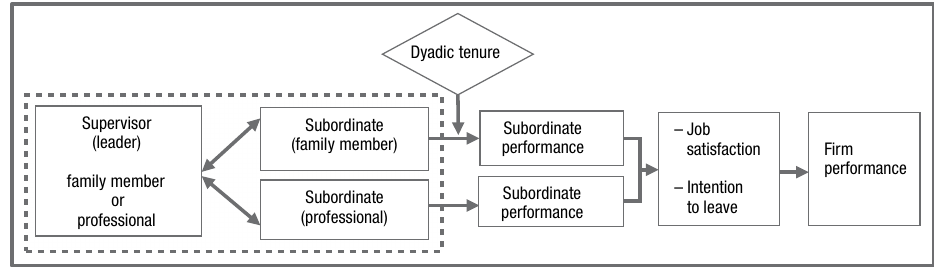
Fig. 2. Proposed research